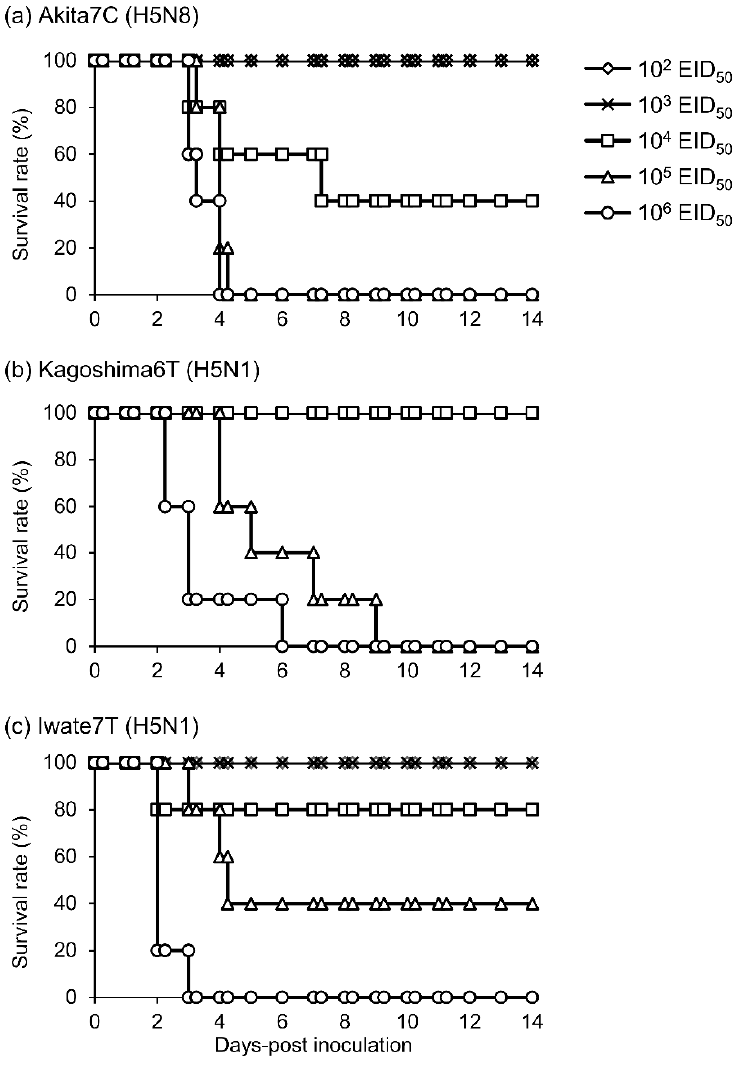
Figure 1. Survival rates of chickens inoculated with ( a ) Akita7C, ( b ) Kagoshima6T, and ( c ) Iwate7T strains. The survival rates of chickens inoculated with 10 2 , 10 3 ,10 4 , 10 5 , and 10 6 EID 50 of each virus are shown by rhombuses, crosses, squares, triangles, and circles, respectively.